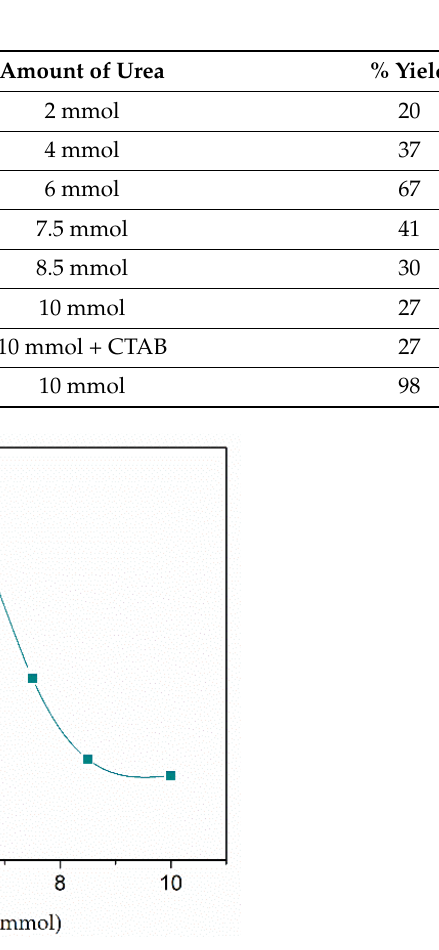
Figure 1. Reaction yield of synthetized materials versus amount of urea.